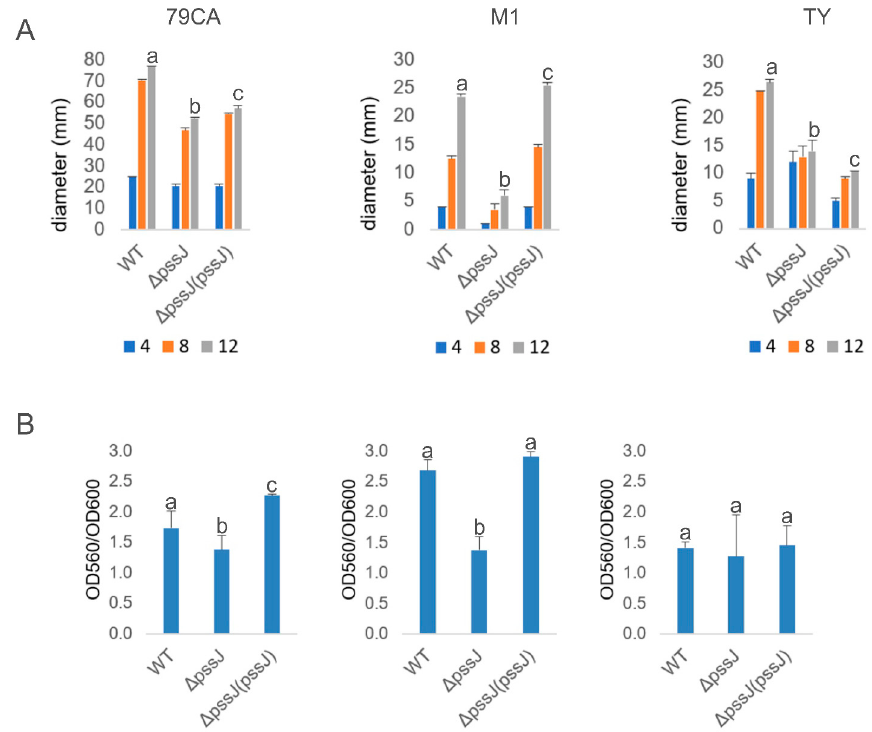
Figure 9. Swimming motility and biofilm formation of the wild type RtTA1 and its derivatives. Swimming motility was measured as the diameter of the zone around the puncture with bacterial suspension on days 4, 8, and 12 after inoculation into media solidified with 0.3% agar ( A ). Biofilm formation was examined by staining with crystal violet and expressed as the ratio of the amount of crystal violet solubilized by ethanol to the bacterial growth (OD 560 / OD 600 ) ( B ). Bars of standard deviation labeled with different letters represent values significantly different at p < 0.05.